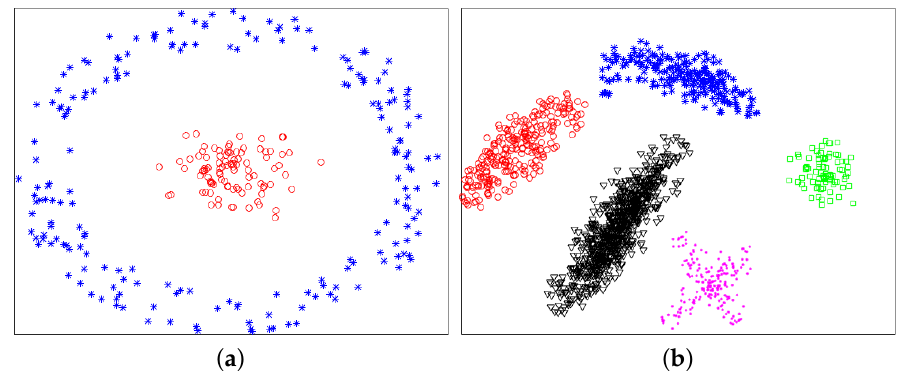
Figure 4. Synthetic datasets. ( a ) Dataset 1. ( b ) Dataset